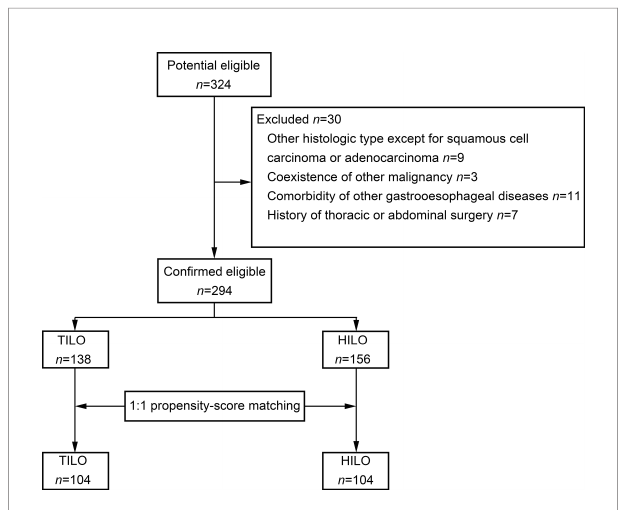
( Figure4A ).Thesubgroupanalysisshowednosigni fi cantdifferences in overall survival rate (stage I, P = 0.206; stage II, P = 0.520; stage III, FIGURE 1 | Flow